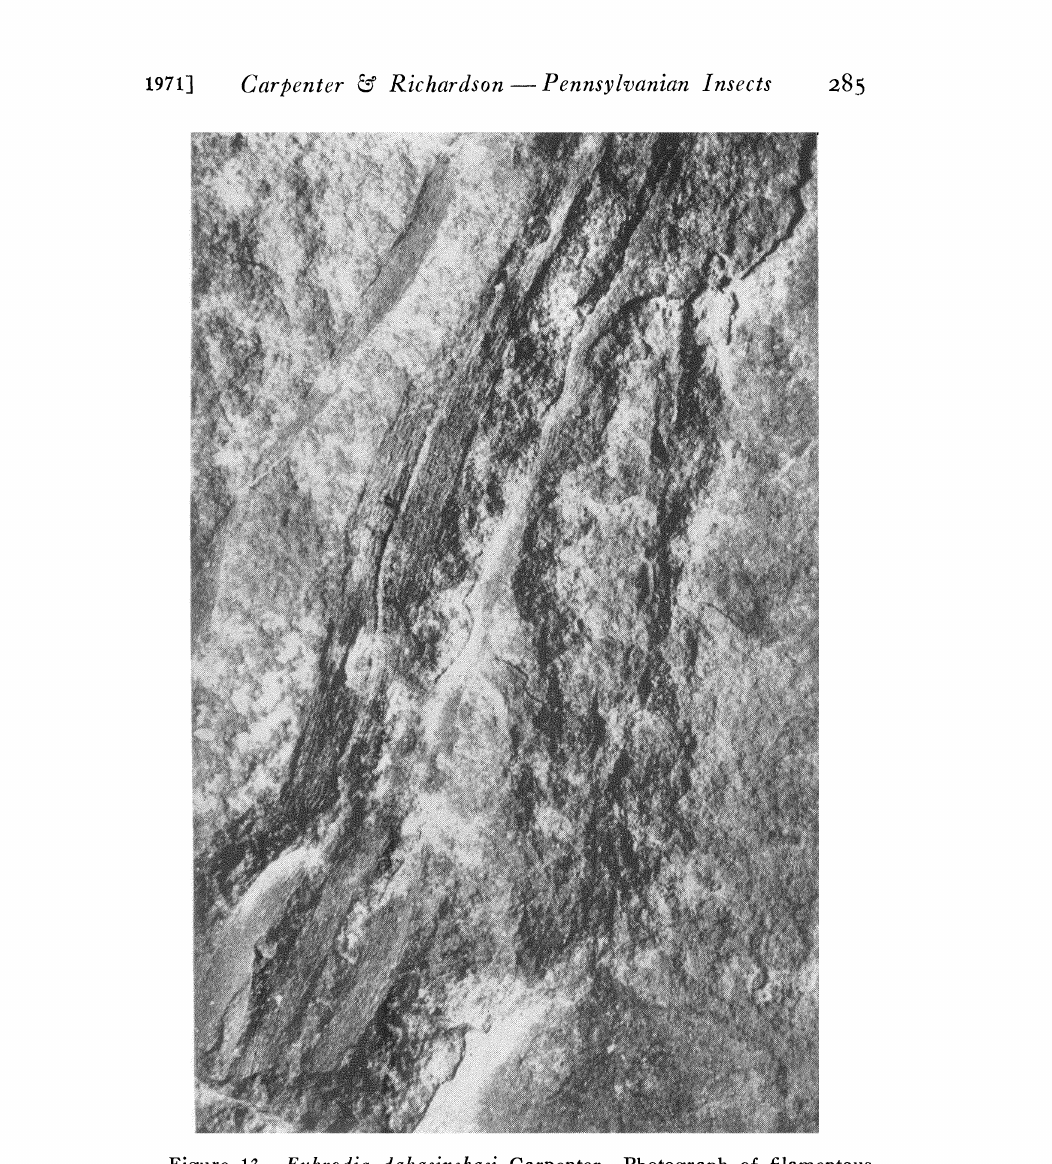
Figure 13. Eubrodia dabasinskasi Carpenter. Photograph of filamentous structures associated with specimen No. HTP 433, Pieeko